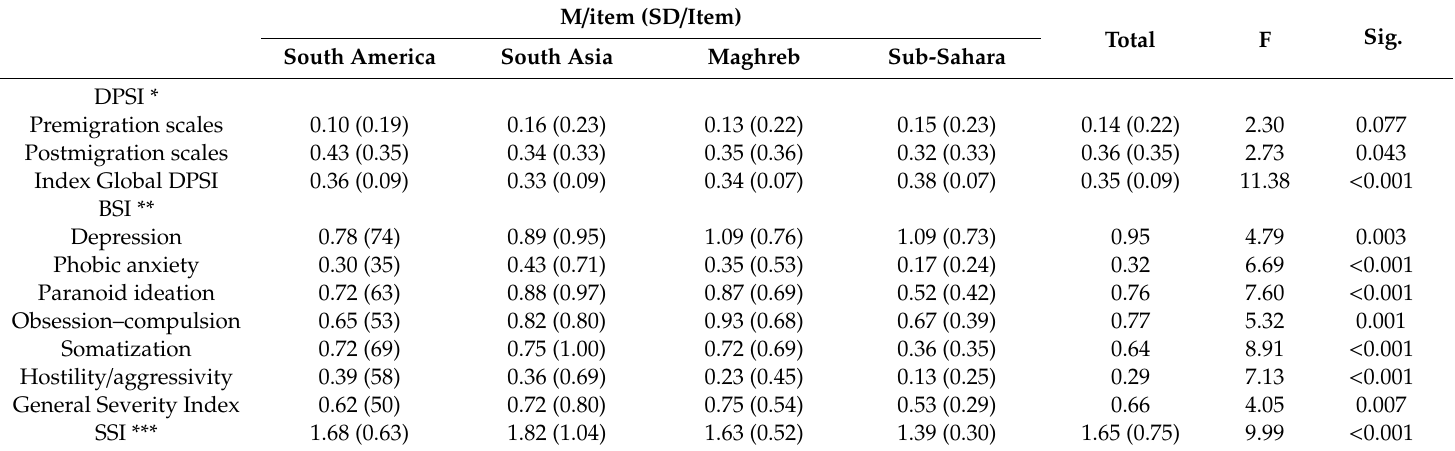
Table 2. Mean and standard deviation of the subscales of the questionnaires and comparison by community. N =